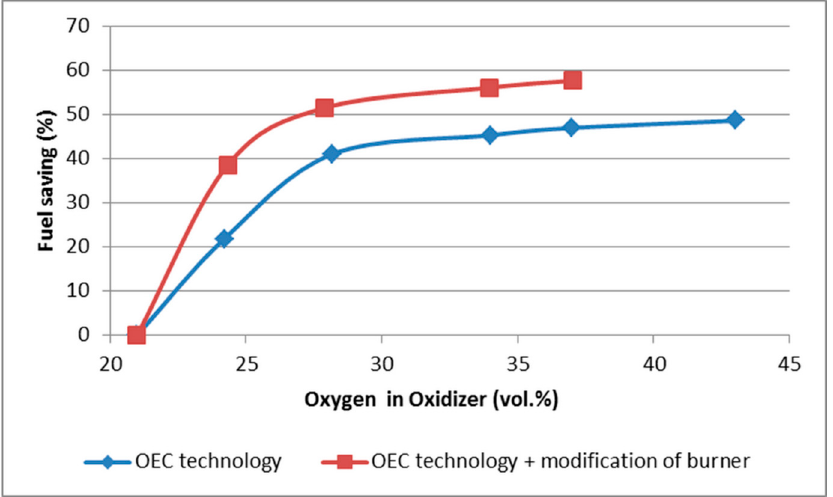
Figure 5. Dependence of fuel savings on oxygen concentration in the oxidant (experimental meas- urements).